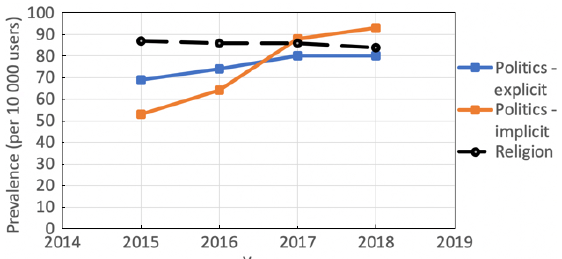
Fig. 3 Prevalence of bio keywords categories, by year— longitudinal sample.